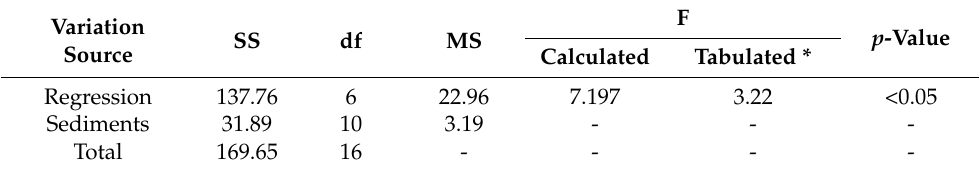
SS = sum of squares, df = degrees of freedom, MS = mean square, F = factor F, p = probability, * Tabulated values for a 95% confidence level (Box et al., 2005).